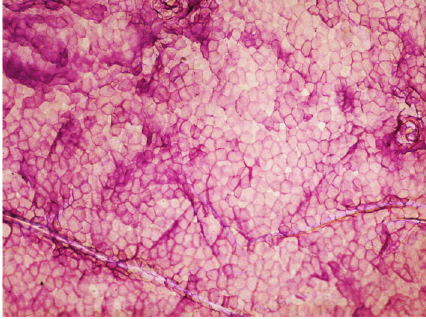
Figure 2: Regular paving of